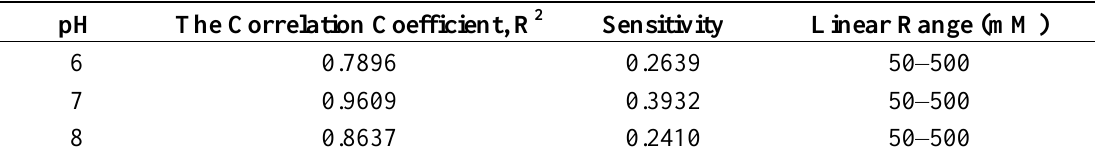
Table 3. The pH effect on urea biosensor response at the wavelength of 650 nm ( n = 3).